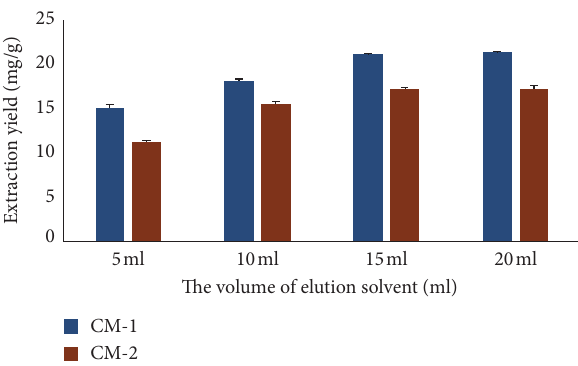
Figure 4: Effect of elution volume on extraction